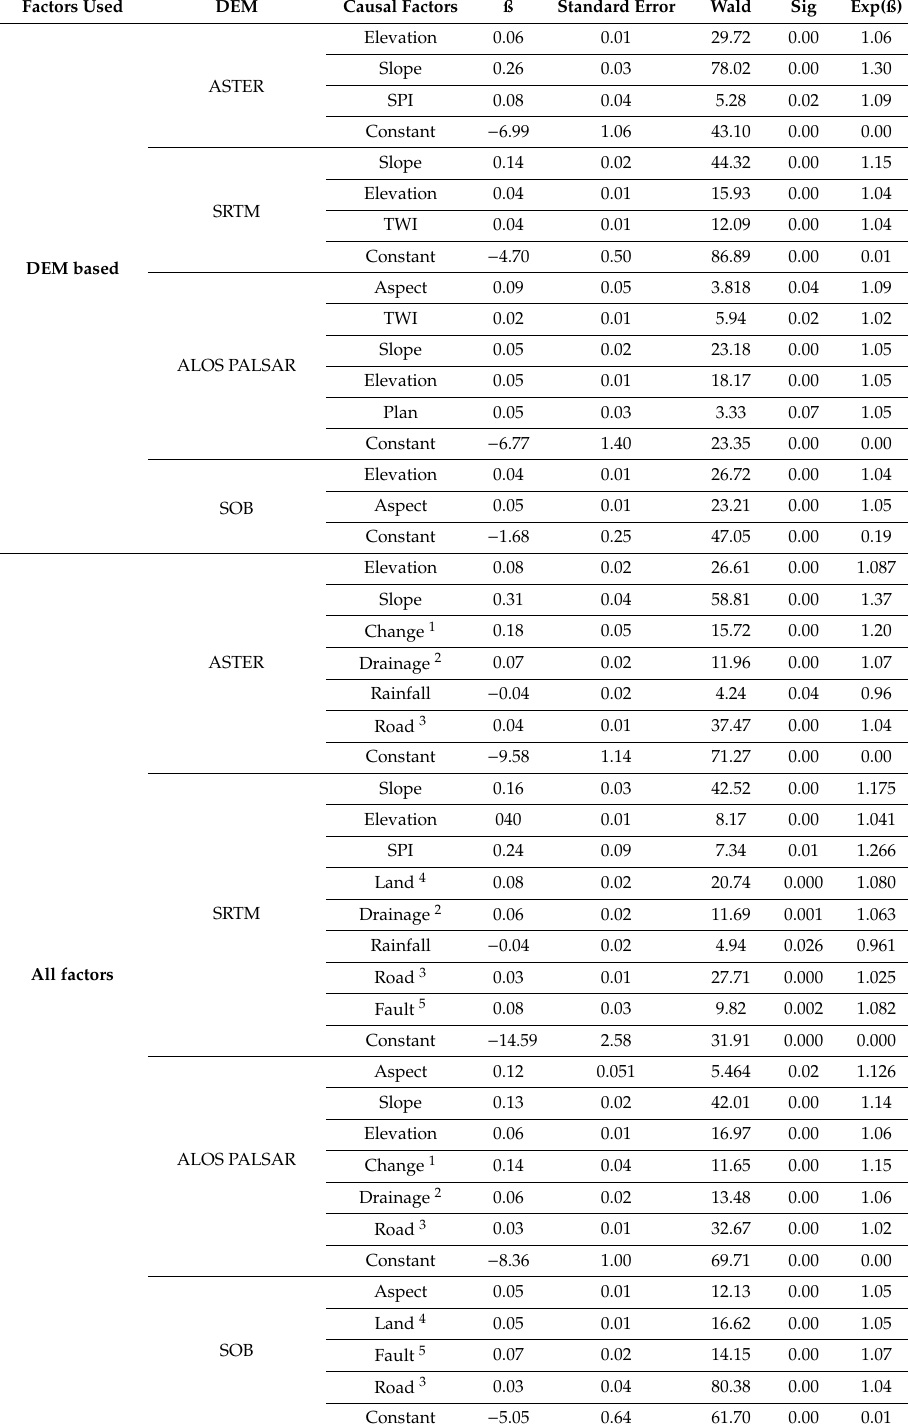
Table A2. Coe ffi cients of significant causal factors of DEM based: LR_ASTER_DEM; LR_SRTM_DEM; LR_ALOS_DEM and LR_SOB_DEM and all factors based: LR_ASTER; LR_SRTM; LR_ALOS and LR_SOB